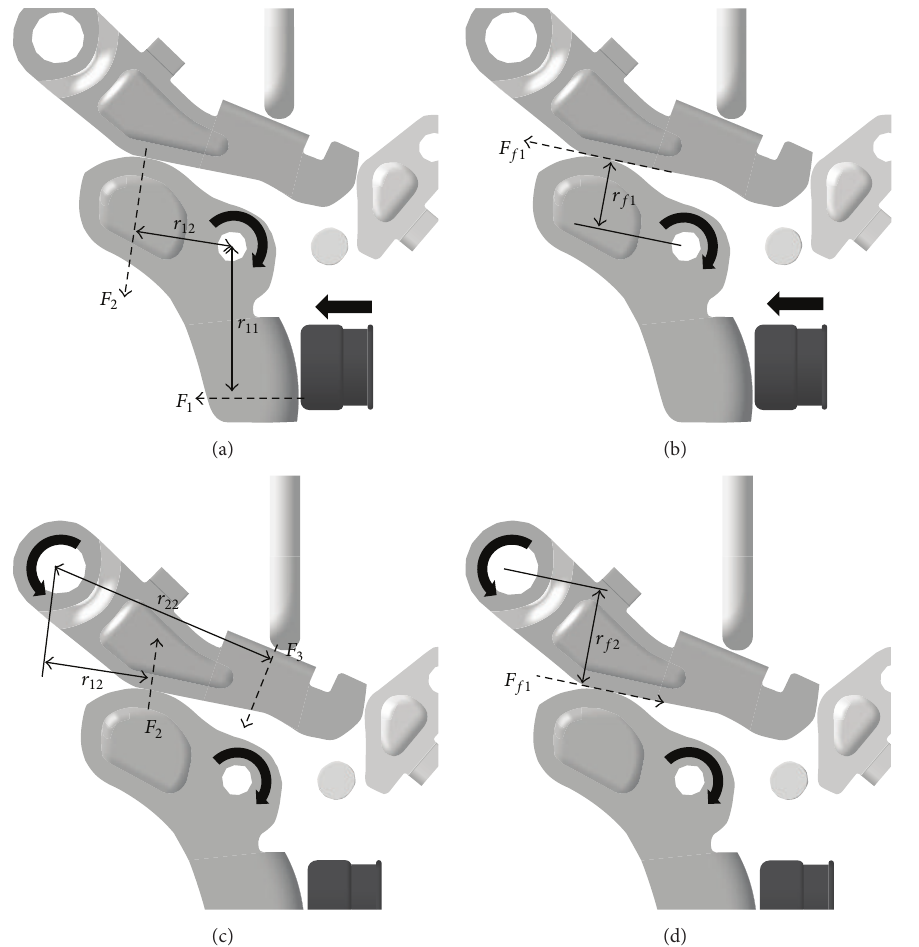
Figure 9: Free body diagram for solving moment at step 2: (a) free body diagram showing forces of bracket release, (b) free body diagram showing friction force of bracket release, (c) free body diagram showing forces of pop-up guide by force, and (d) free body diagram showing friction force of pop-up guide showing force of emergency